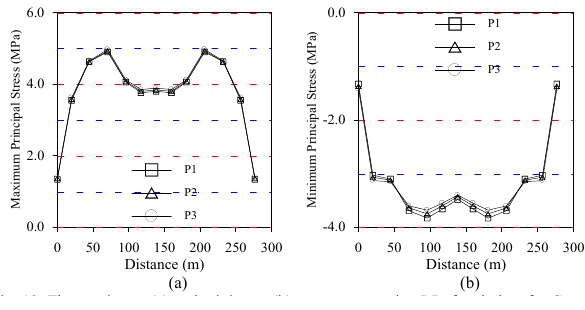
(b) Fig. 13. The maximum (a) and minimum (b) stresses at section I-I of arch dam for Case P. Fig. 13. The maximum (a) and minimum (b) stresses at section I-I The time histories of maximum principal stresses (tensile stress) at nodal point 48, which is of arch dam for Case the most representative crest point of downstream side of the dam, for each case are plotted by displaying the demand-capacity ratios (DCR) in Fig. 14 (a-c). It is clearly seen from Fig. 14 that some values of maximum principal stresses are over than DCR=1 for all cases. It means that the maximum principal stresses occurred on the dam are much more than tensile strength of concrete used in dam body.